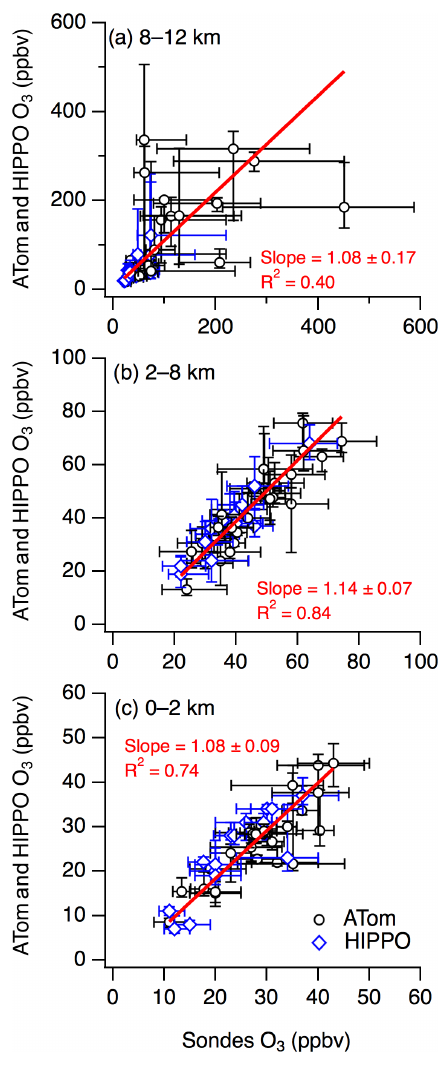
Figure 4. ATom (black circles) and HIPPO (blue diamonds) com- bined monthly median O 3 vs. monthly median O 3 from ozoneson- des at the nine sites considered in this study. The three panels indi- cate the correlations for (a) the UTLS (8–12km), (b) the free tropo- sphere (2–8km), and (c) the boundary layer (0–2km). The orthog- onal regression fits are two-sided but not